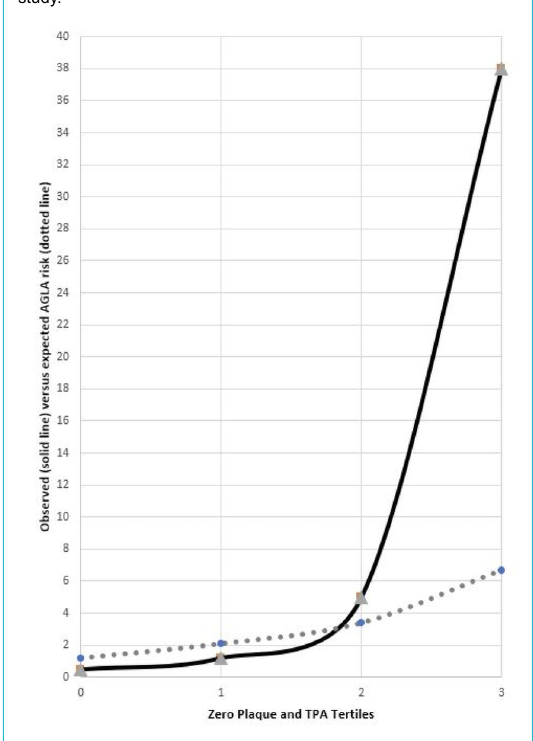
Figure 2: Observed events (solid) and AGLA-AMI prediction (dot- ted line) plotted by zero plaque and TPA tertiles in the ARCO